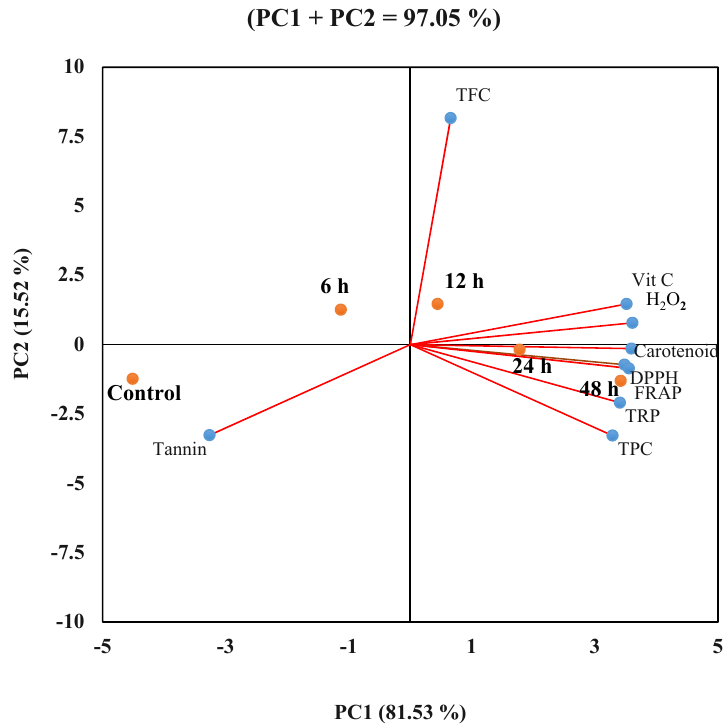
Figure 1. Principal Component Analysis (PCA) of fermented “Nabag” ( Ziziphus spina-christi L. ) seeds, phytochemical compound contents (TPC, TFC, tannin, vitamin C, and total carotenoid), and antioxidant activities (DPPH, FRAP, TRP, and H 2 O 2 ).